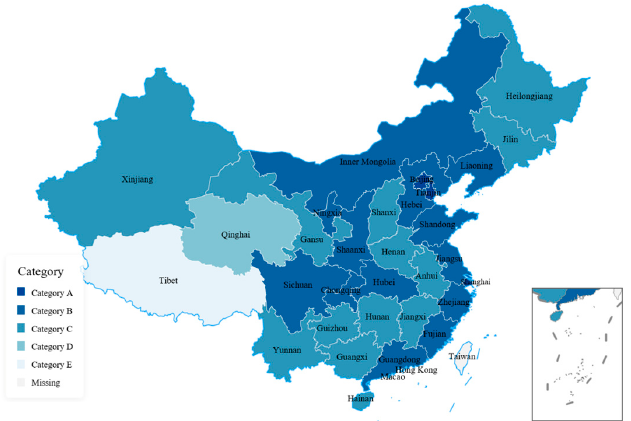
Figure A1. Regional healthy environment categories in 2020.